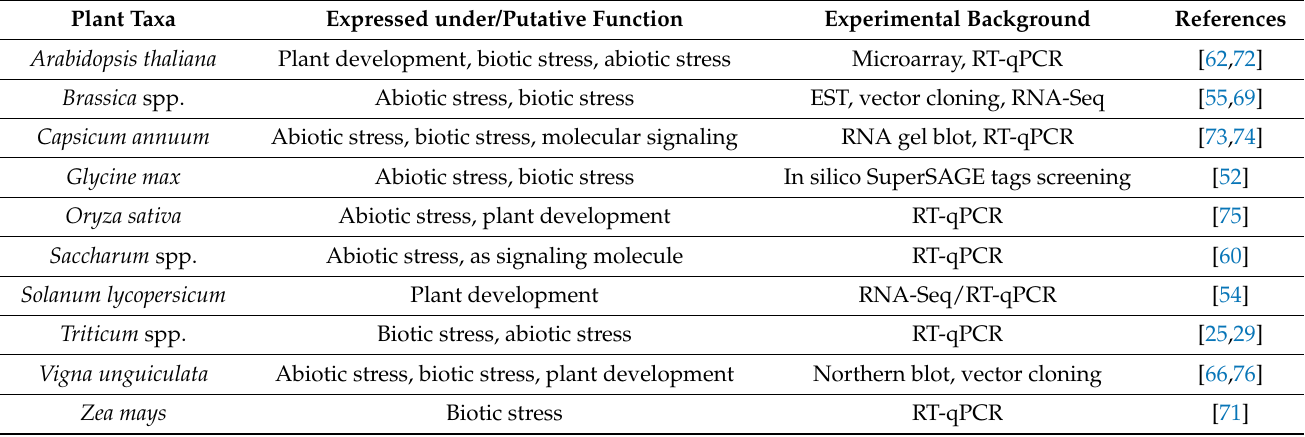
Table 1. Survey of stress situations, putative functions and expression of ns LTPs in different plant species. Plant Taxa